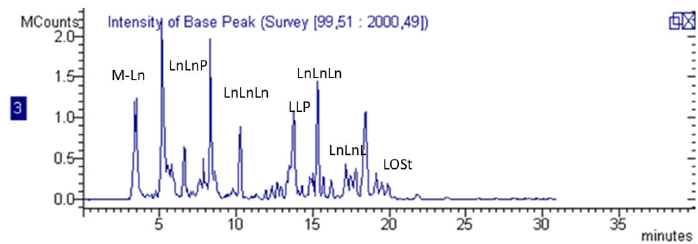
Figure 5. LC/APCI-MS TIC of the SCO 2 extract from Eruca leaves.